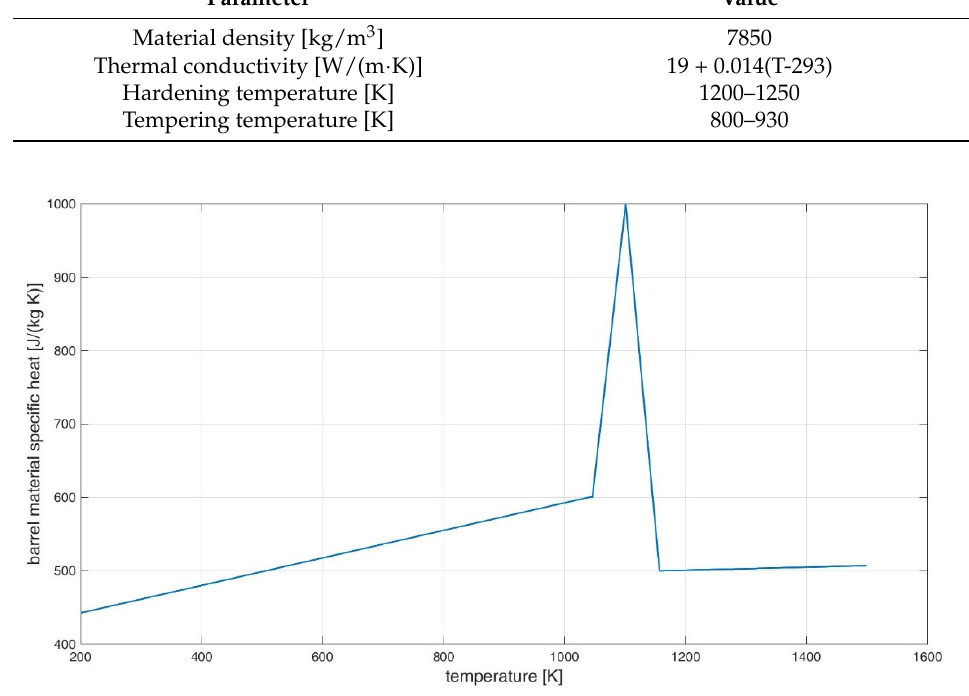
Figure 11. Approximation of barrel material specific heat as a function of temperature.